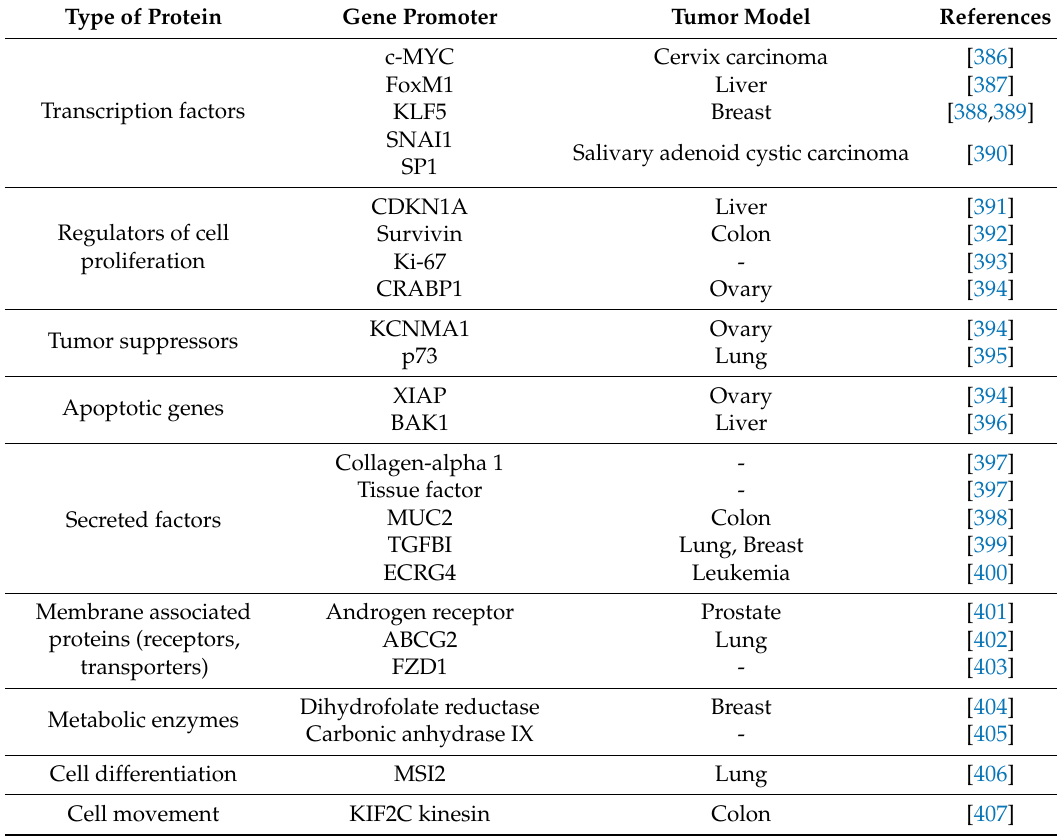
Examples of mithramycins deregulated genes that occurs upon inhibition of SP1 transcription